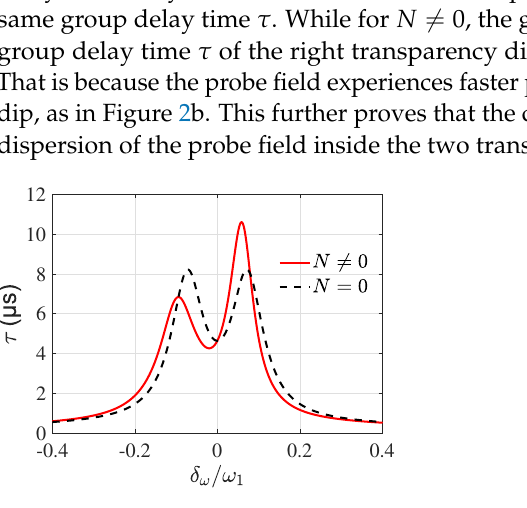
Figure 6. The optical group delay time as a function of the normalized frequency δ ω / ω 1 . The other parameters are the same as given in Figure